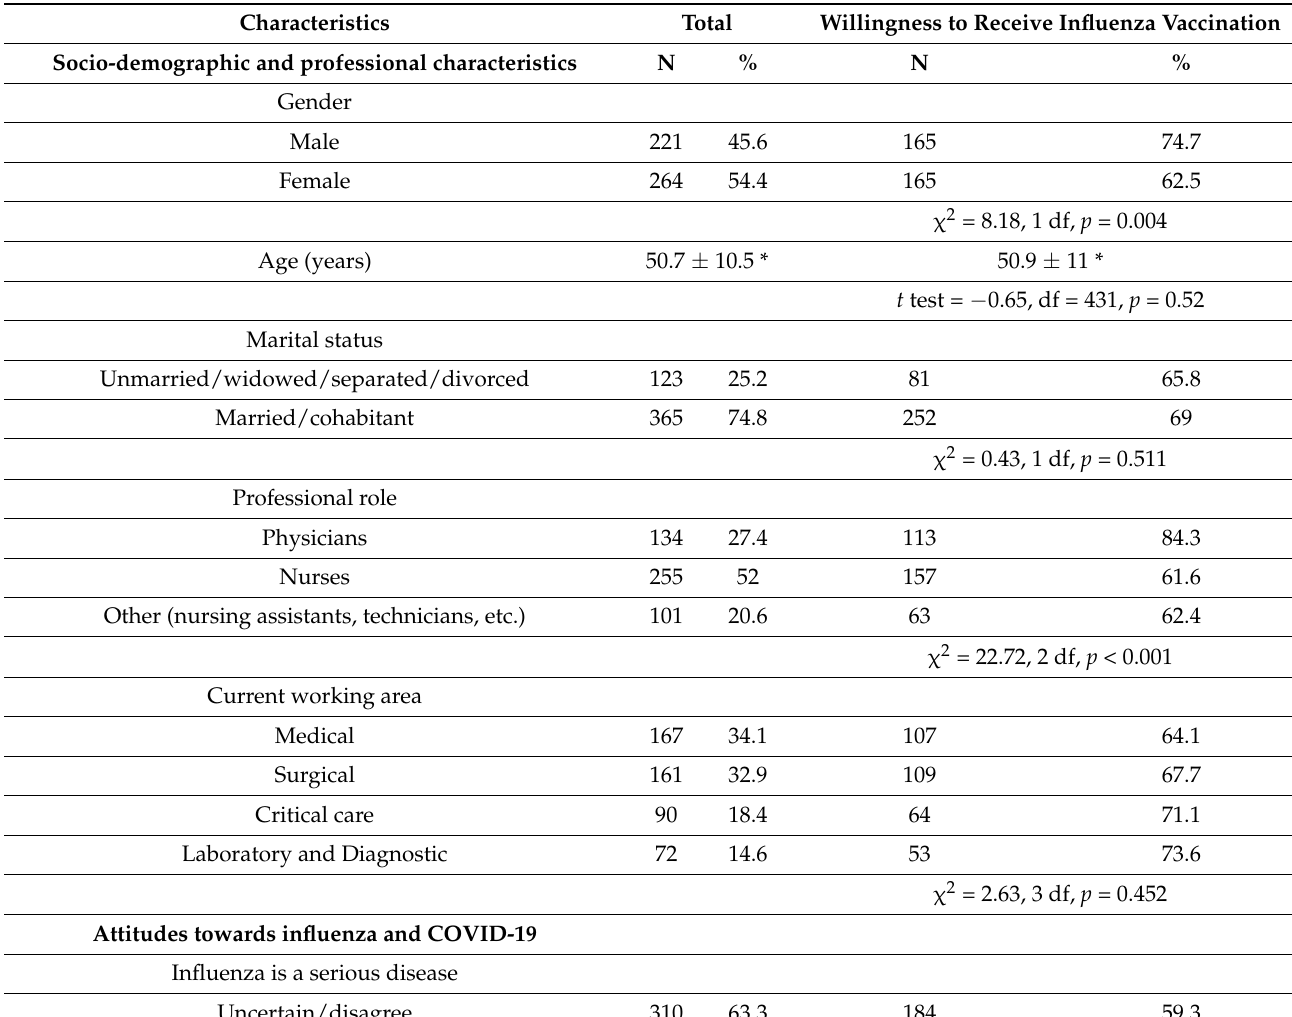
Table 1. Willingness to receive influenza vaccination during the 2020/21 season according to several